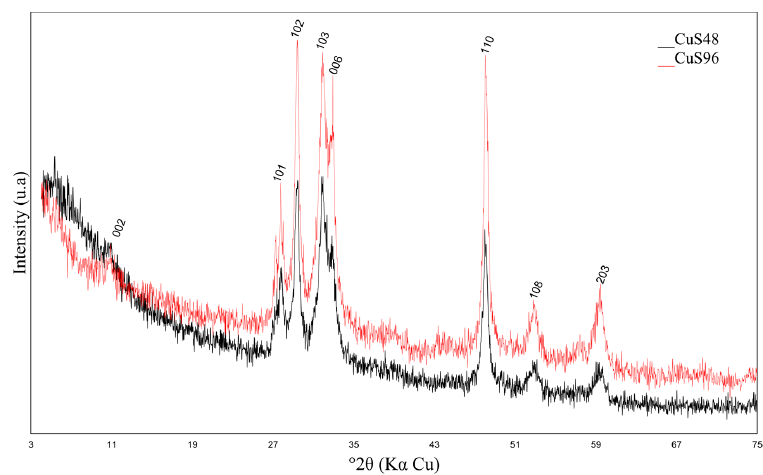
Figure 3. X-ray diffraction (XRD) diffractograms of the mineral precipitate obtained after 48 h (CuS48) and 96 h (CuS96) of AMD sample exposure to biogenic H 2 S.